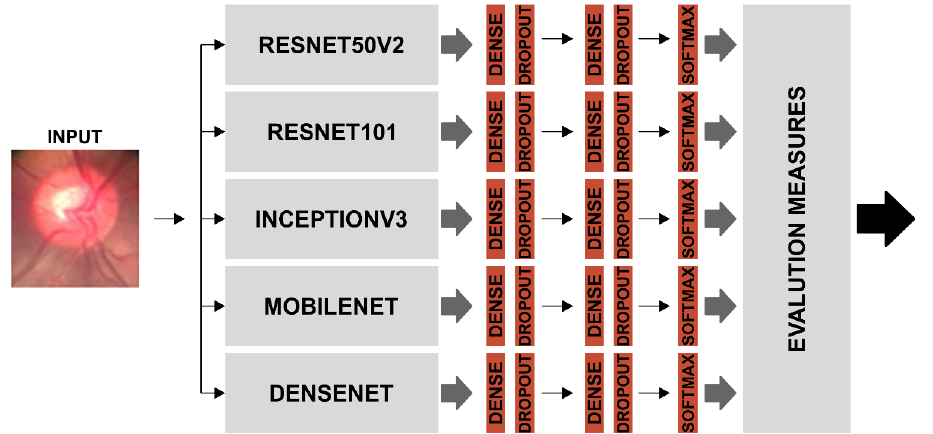
Figure 13. Ensemble model using the individual classifiers that was most accurate in classifying BrG dataset images.